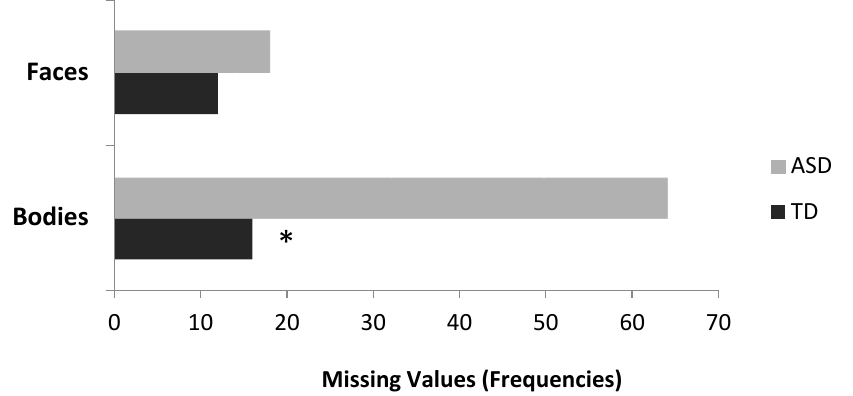
Figure 6. Frequencies of missing values for bodiless heads and headless bodies distinguished by